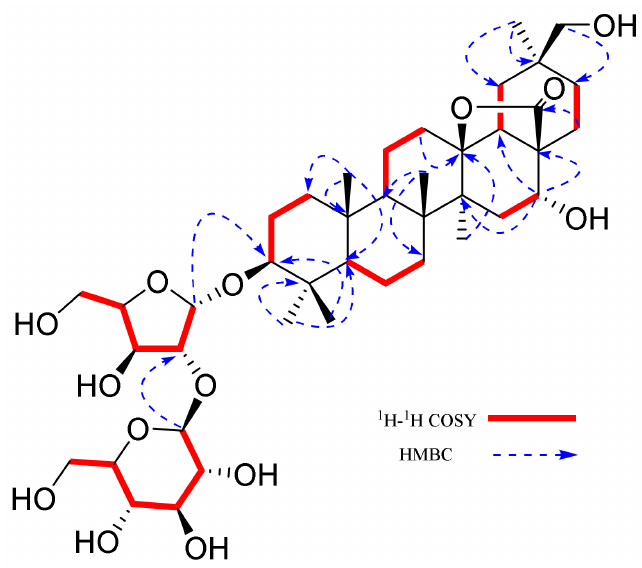
Figure 1. Key HMBC and 1 H- 1 H COSY correlations of ardisiacrispin D ( 1